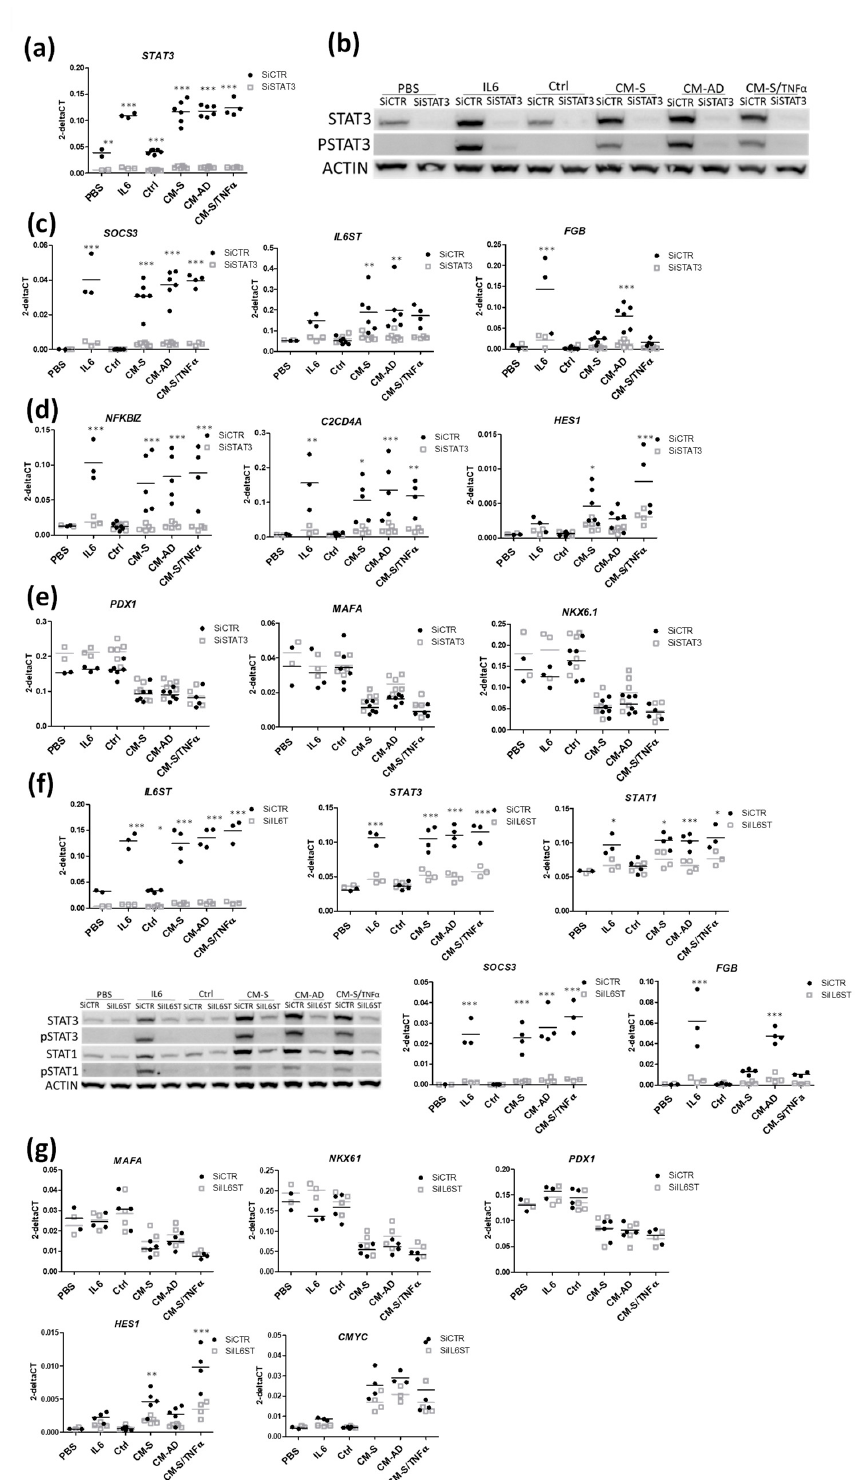
Figure 5. Role of STAT1 and STAT3 pathways in the effects of CM from omental stromal cells on beta cell identity. EndoC- β H1 cells were transfected with control non-target siRNA (siCTRL) or siRNA-targeting STAT3 (siSTAT3) ( a – e ) or IL6ST (siIL6ST) ( f , g ). Two days later, cells were treated with either IL6 or CM for 48 h. Analyses were performed by either RT-qPCR or Western blot. Data are represented as mean ± SD of 4–6 biological replicates. * p < 0.05, ** p < 0.01, *** p < 0.001.